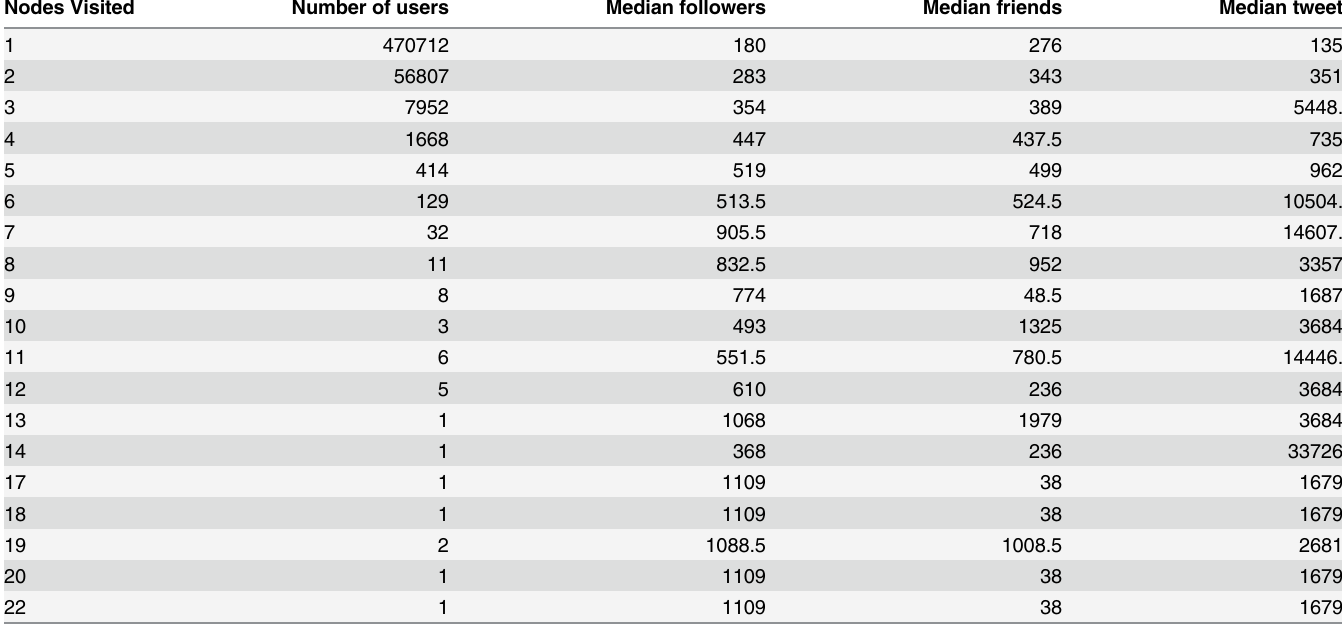
Table 2. Characteristics of Twitter users by movement